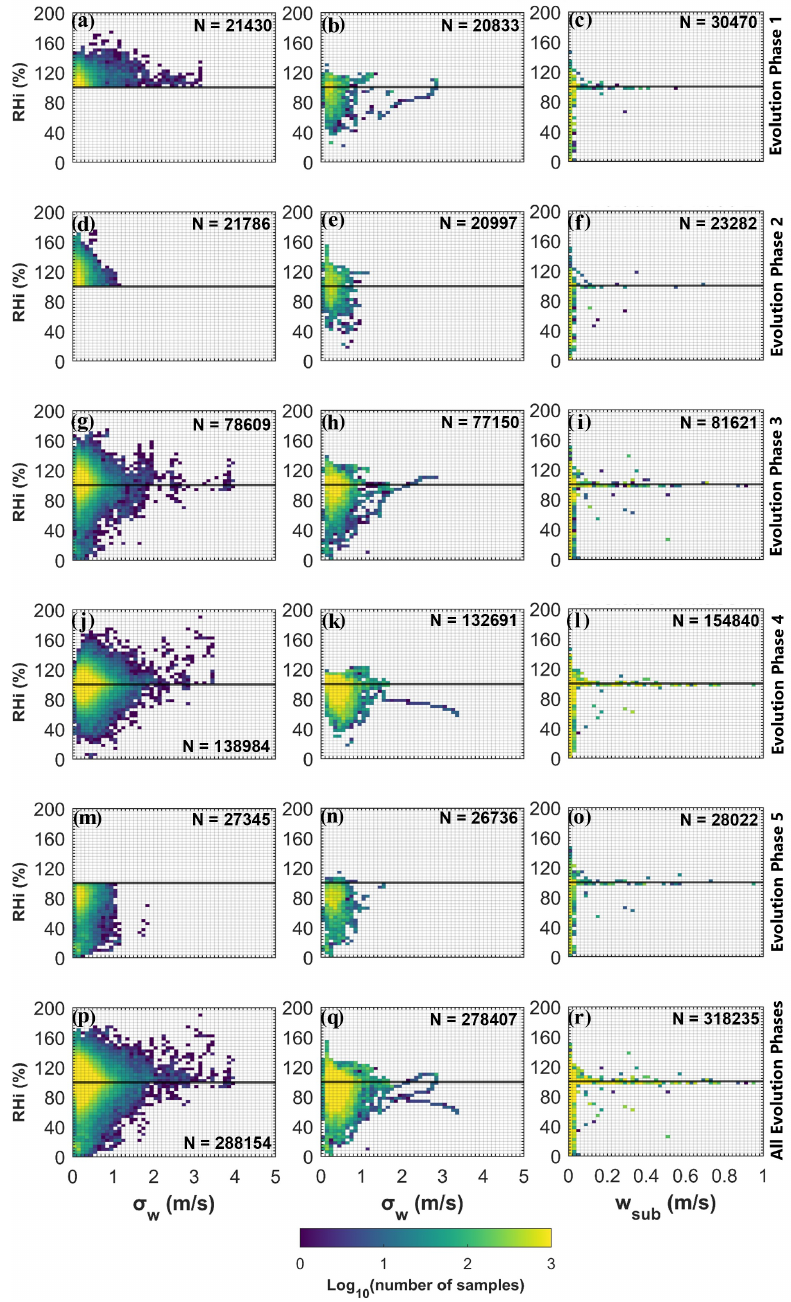
Figure 17. Similar to Fig. 16, except for distributions of σ w in relation to temperature.